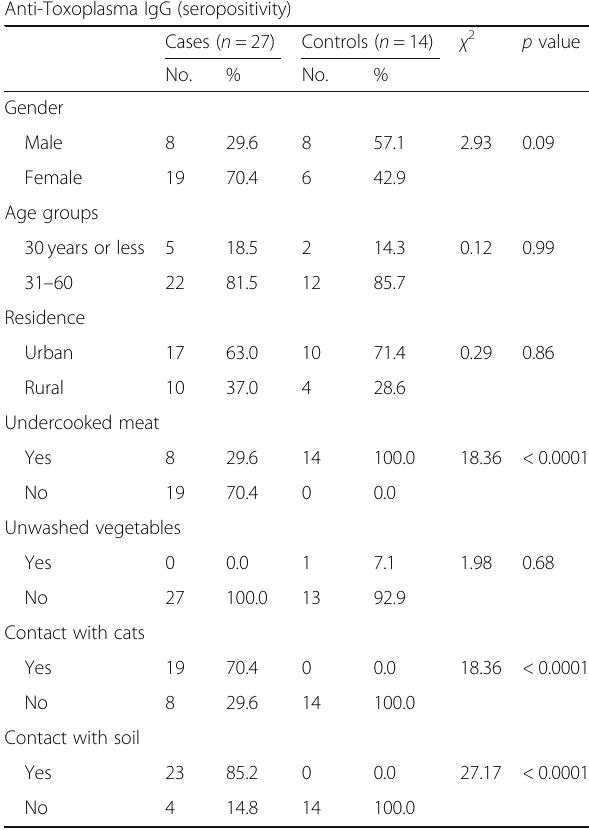
Table 3 Relation between anti-Toxoplasma IgG prevalence and sociodemographic data among patients and control groups Anti-Toxoplasma IgG (seropositivity)